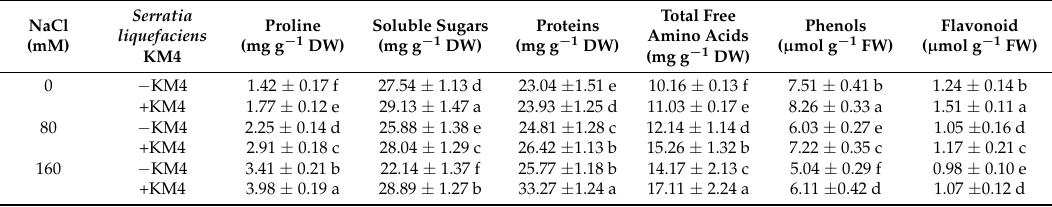
Table 4. Levels of osmoprotectants and antioxidants in maize leaf in the presence or absence of Serratia liquefaciens KM4 under saline